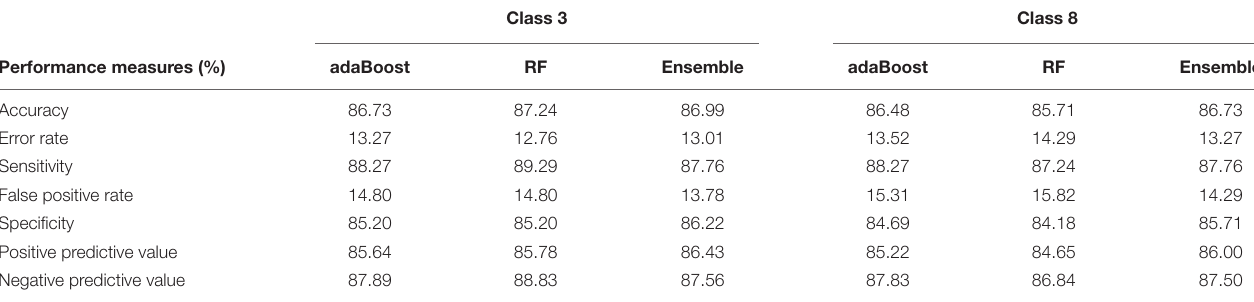
TABLE 3 | Machine learning performance measures for predicting exportome membership using 3 and 8 class conformational state predictions.